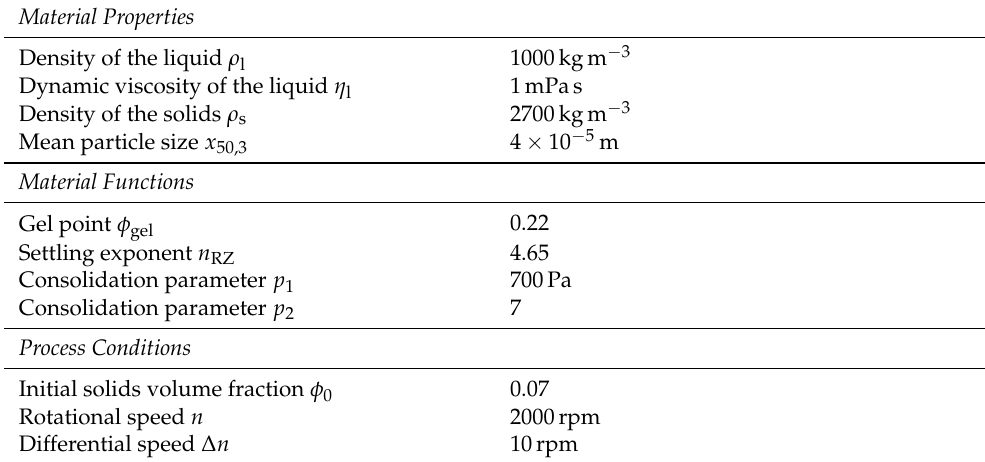
Table 2. Material characteristics and process conditions of the